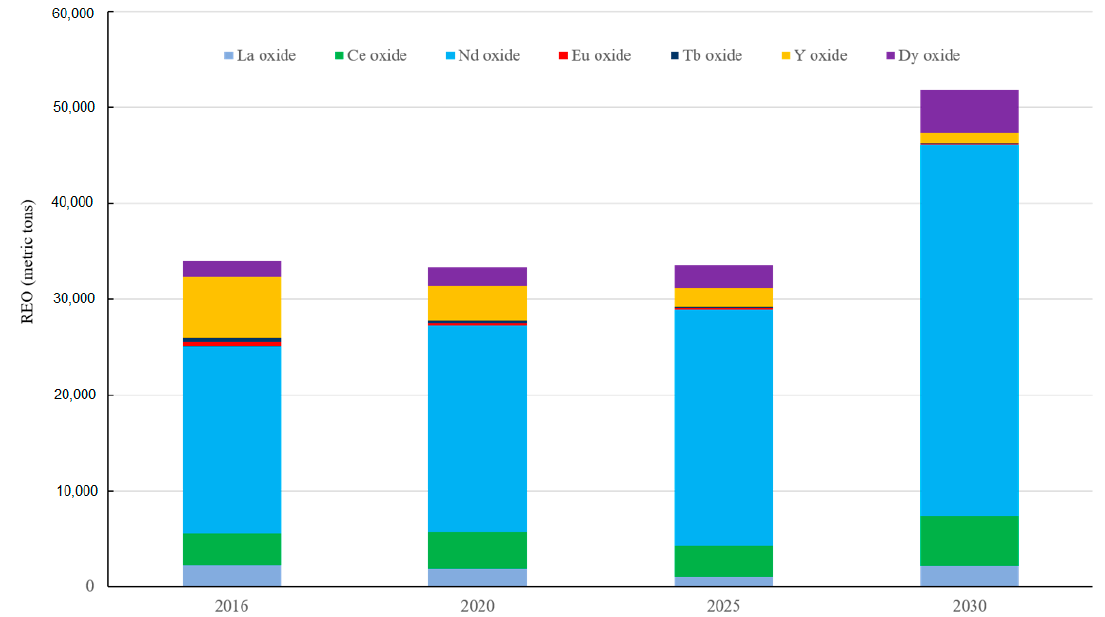
Figure 9. Global demand for REO from clean technologies in 2016, 2020, 2025, and 2030.